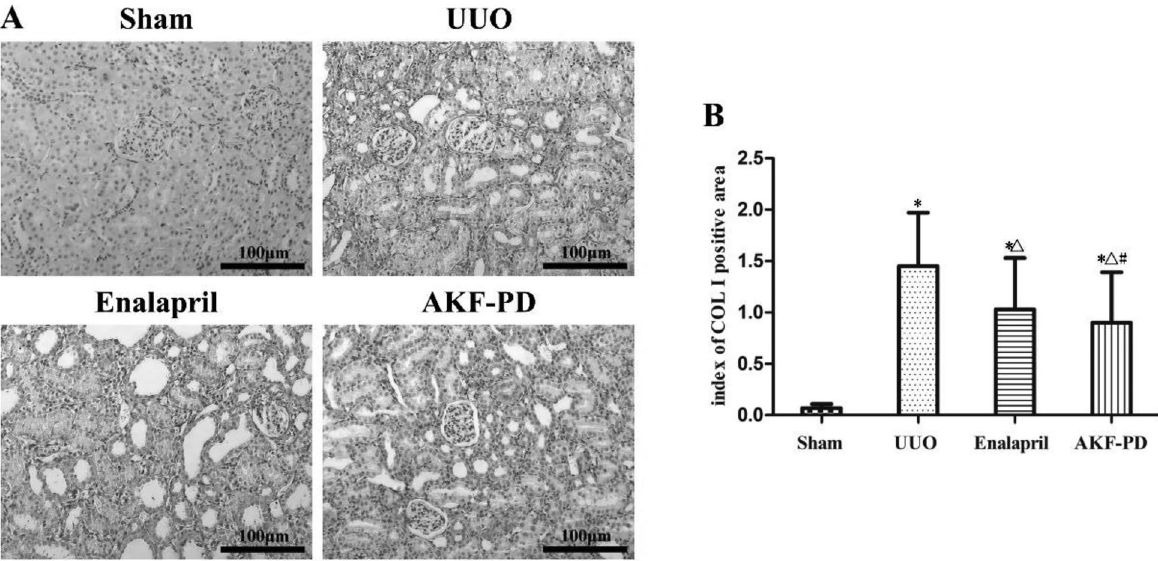
Figure 3. Fluorofenidone (AKF-PD) downregulated the expression of Col I in the renal interstitium of rats in the unilateral urinary obstruction (UUO) group. A , Immunohistochemistry results of Col I in the sham, UUO, UUO + enalapril, and UUO + AKF-PD groups